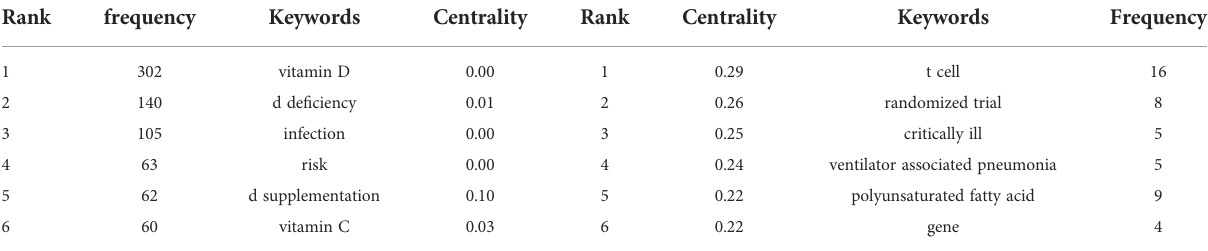
TABLE 8 Top 6 frequency and centrality of